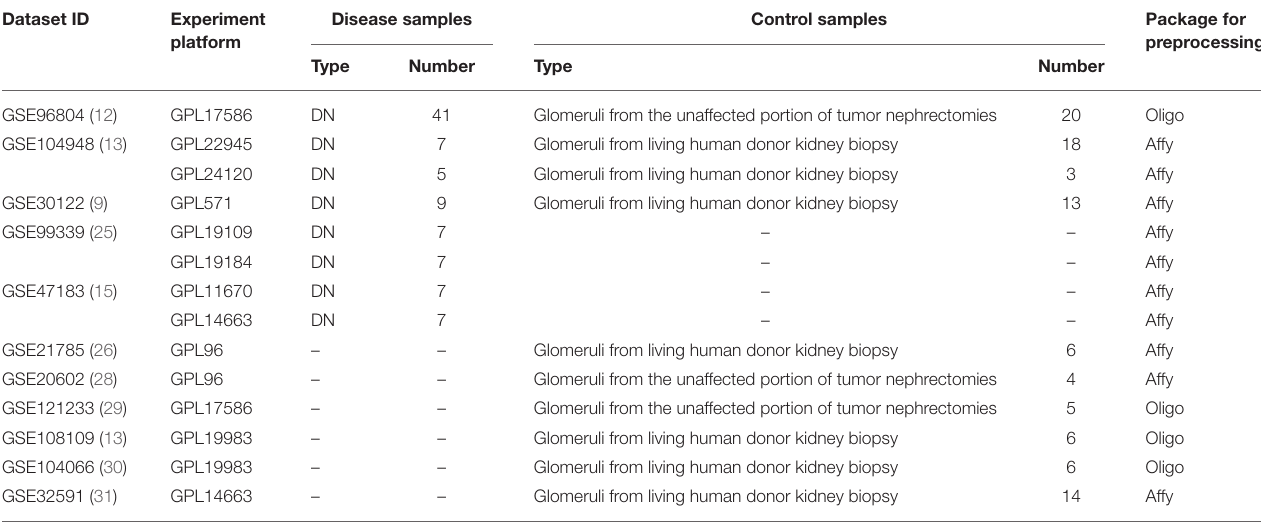
TABLE 1 | The microarray datasets collected and used in this